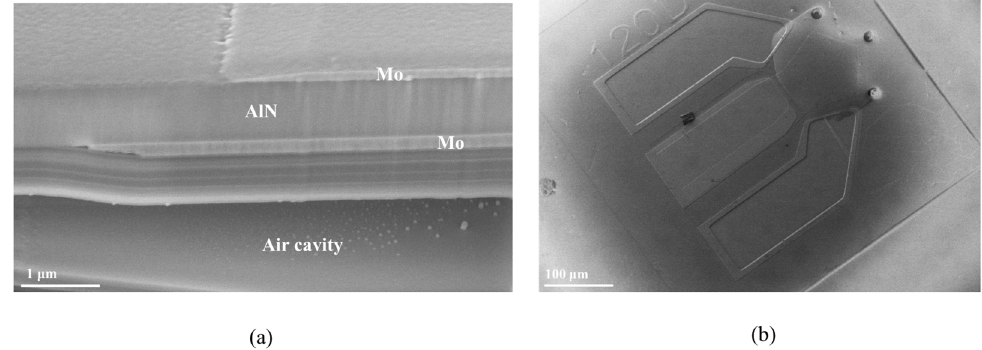
Figure 3. Macro photograph of fabricated device, ( a ) Cross-sectional view of the active area in the resonator, ( b ) SEM image of the resonator, ( b ) SEM image of the resonator.